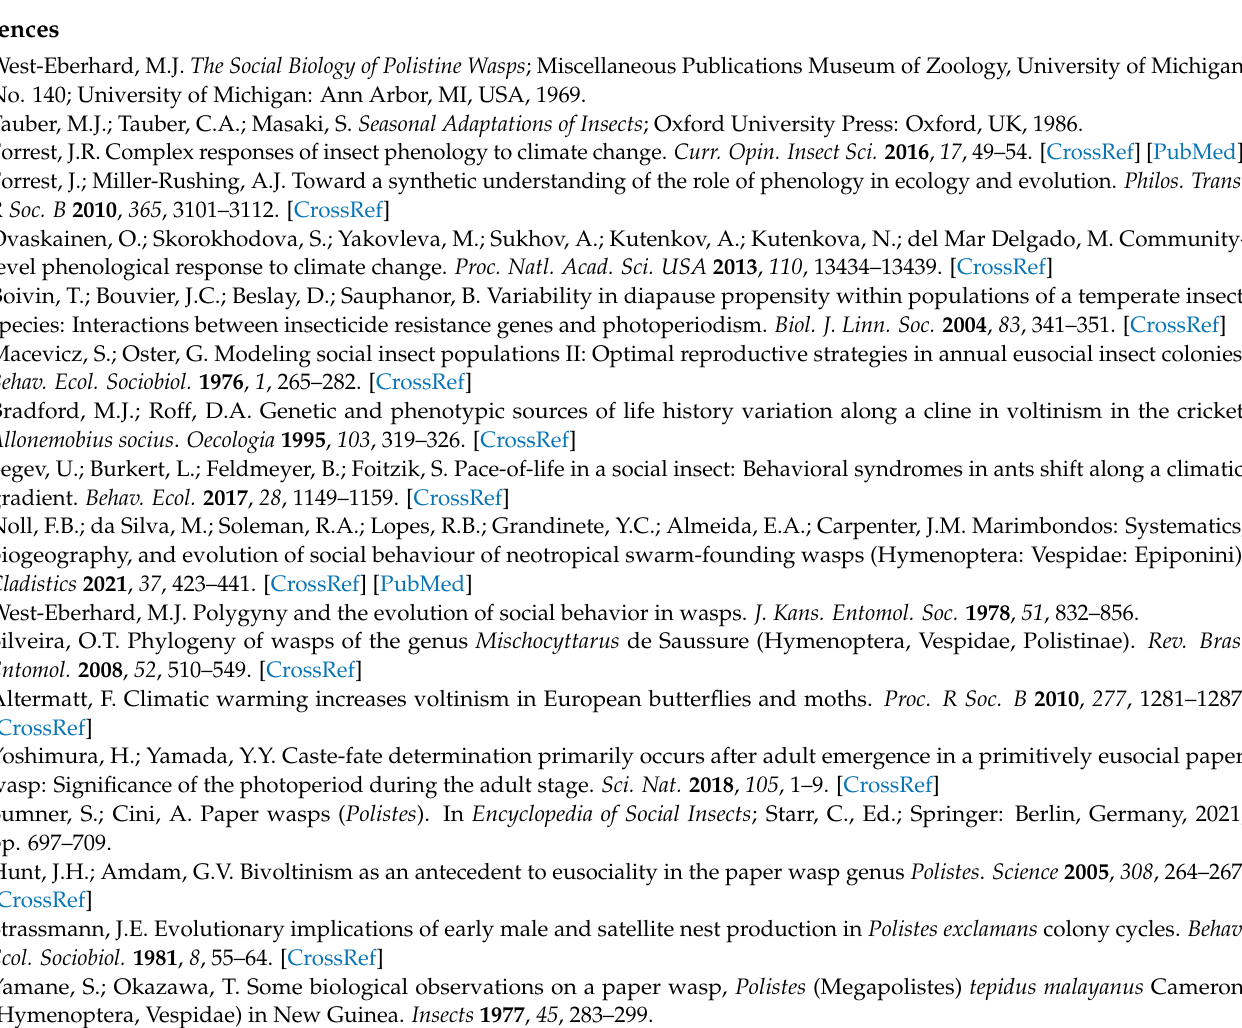
Figure S3: Colony parameters GLS residuals, Figure S4: Day length correlation, Table S1: Duration pairwise comparisons, Table S2: Nest parameter model significance, Table S3: Foundress model significance, Table S4: Early season raw data, Table S5: Late season raw